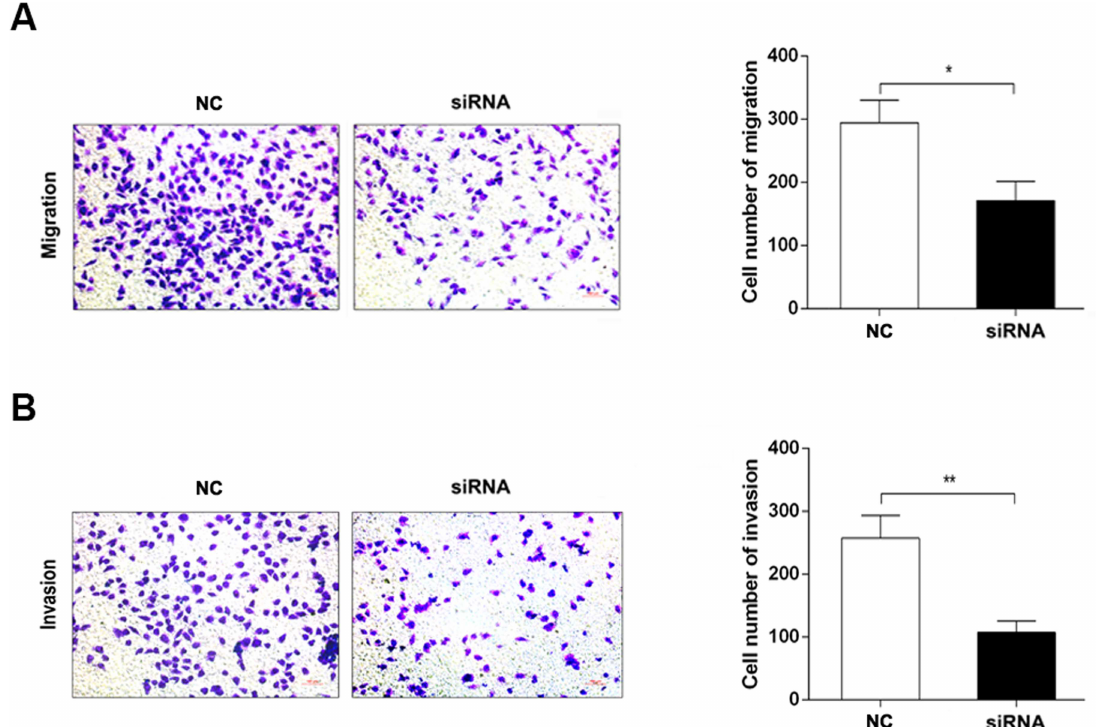
Fig 7. Effects of Derlin-1 on the migration and invasion in T24 cells. (A) Effects of Derlin-1on cellularmigrationability. (B) Effects of Derlin-1on cellularinvasionability. Representative microscopy images of the migration and invasionassay are shown as × 100. NC, siRNA negative control; siRNA, Derlin-1 siRNA. * P < 0.05, ** P <